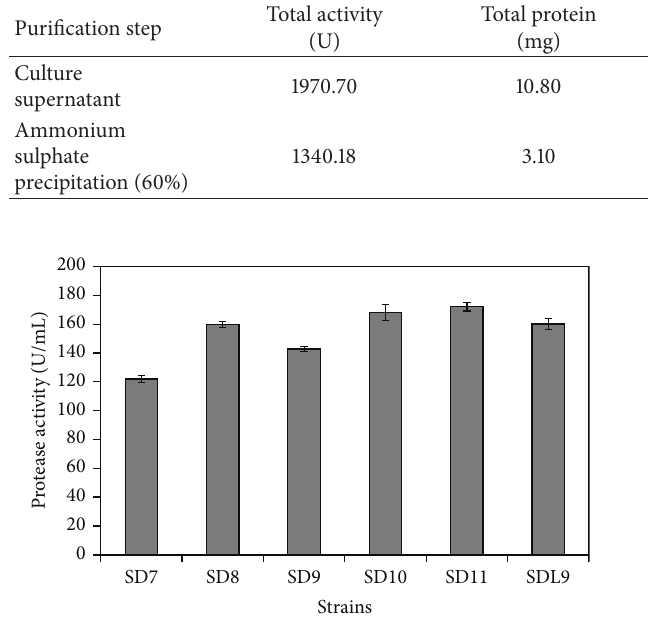
Figure2:Proteaseactivityofculturesupernatantofdifferentstrains.